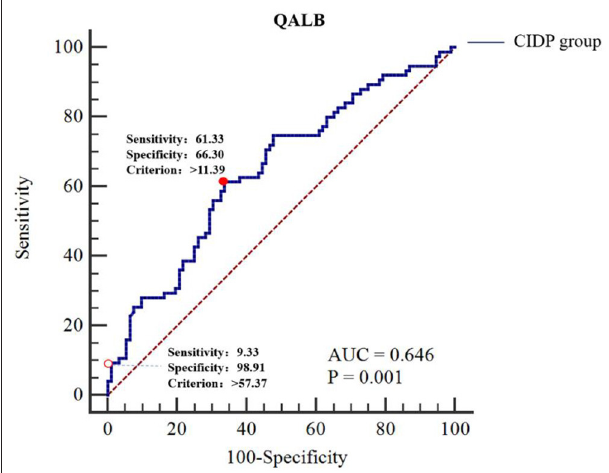
FIGURE 3 | ROC curve analysis of QALB in the GBS and CIDP groups. The GBS group was used as the reference group, and the CIDP group was used as the measurement